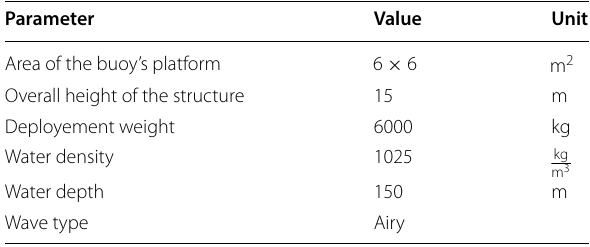
Table 1 Physical properties of simulated